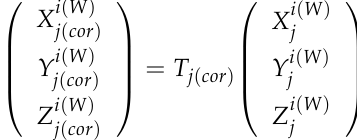
( c ) Figure 5. The 3D point cloud densification and loop closure correction: ( a ) sparse point cloud; ( b ) dense point cloud; ( c ) dense point cloud loop closure correction. In order to analyze the robustness and availability of the reconstruction method pro- posed in this paper with a single-line lidar, this paper collects data from forest areas with undulating terrain and a messy arrangement of trees, and a 3D point cloud map is ob- tained. The reconstruction map is shown in Figure 6. It can be seen that, in the area with rich environmental features, the 3D point cloud is well preserved and tree reconstruction is more intensive. In the area with sparse environmental features, localization also has